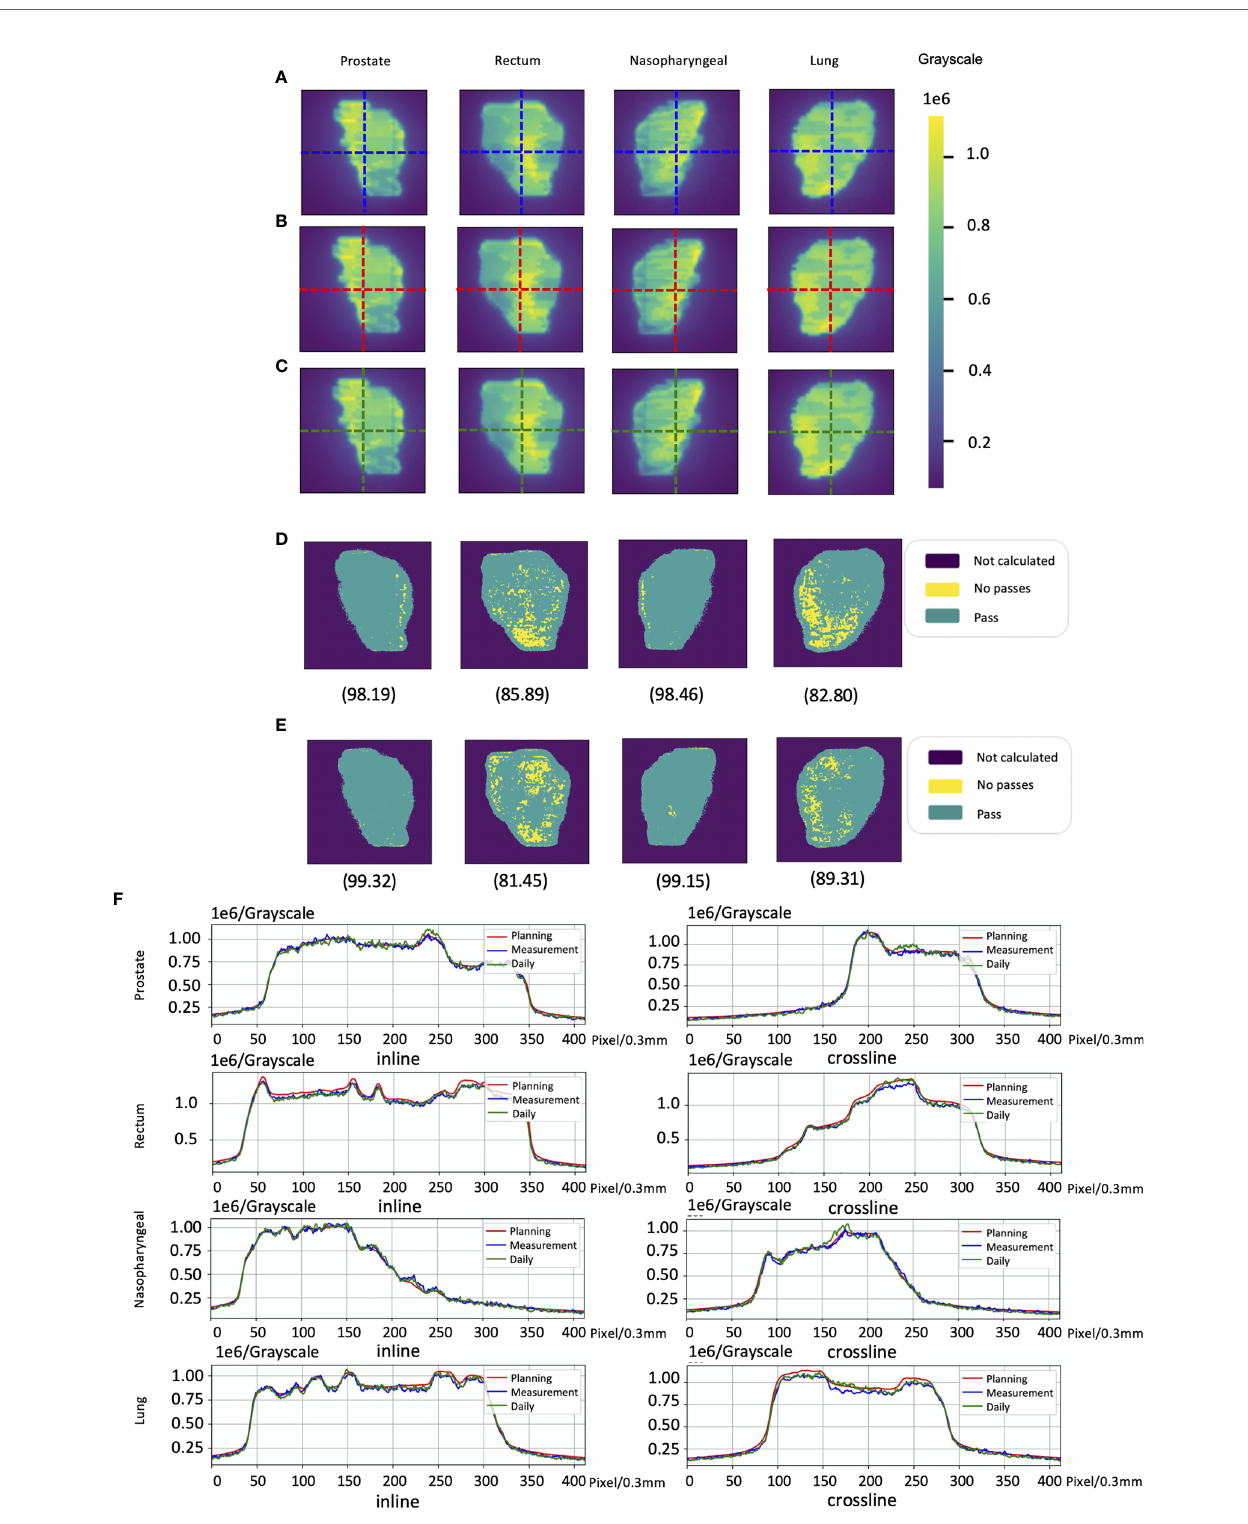
FIGURE 8 | The cases of electronic portal image device (EPID)-based in vivo dosimetry during treatment. (A) An EPID-measured image. (B) A planning CT (pCT)- based calculated image. (C) A daily CT (dCT)-based calculated image. (D) The corresponding Gamma analysis results between the pCT and measurement. (E) The corresponding Gamma analysis results between the dCT and measurement. (F) Pro fi les representing inlines and crosslines are shown in panels (A – C)